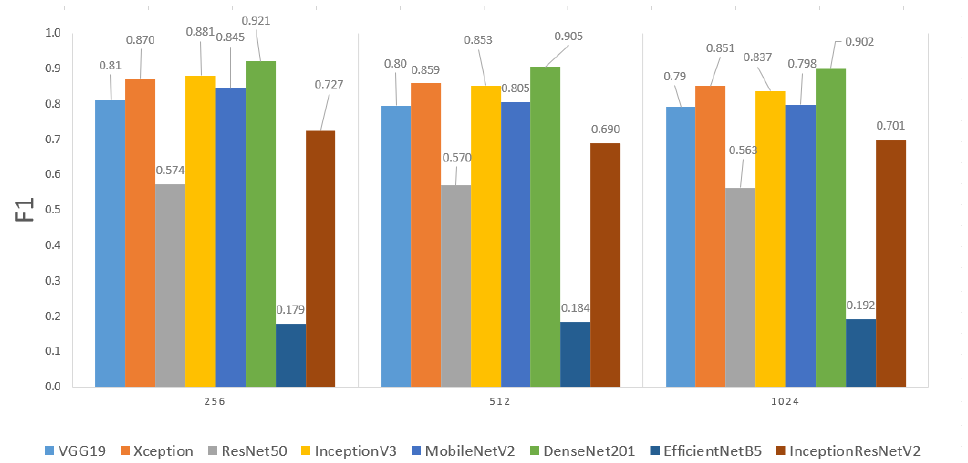
Figure 8. Summary of evaluation results by the number of neurons in the last FC layer (except the output layer), in terms of F1-score.